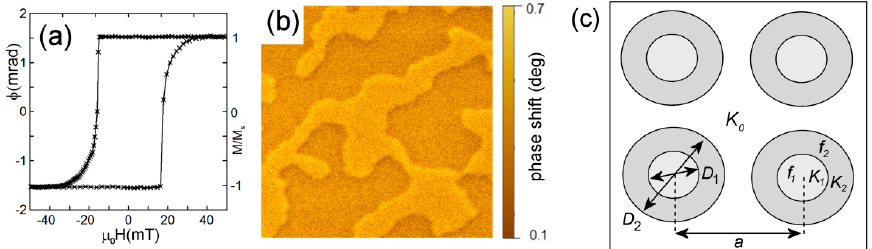
Figure 1. (Color online) ( a ) Typical polar MOKE hysteresis loop of the initial Co / Pt film. It demonstrates easy-axis perpendicular anisotropy. ( b ) 3 × 3 μ m 2 MFM image of labyrinth domain structure in the initial Co/Pt film in a remnant state. ( c ) The geometry of nanomodification: the irradiated spots with the reduced anisotropy form a rectangular lattice with the period of 200 and 300 nm). D 1 and D 2 are the diameters of the regions with different irradiation fluence ( f 1 and f 2 , correspondingly) and anisotropy ( K 1 , K 2 ). Table 1. Parameters of the investigated nanostructured films: D 1 and f 1 are the diameter and the irradiation fluence of the central part of a spot (Figure 1), D 2 and f 2 are the same for the outer ringed region, and a is the lattice period.